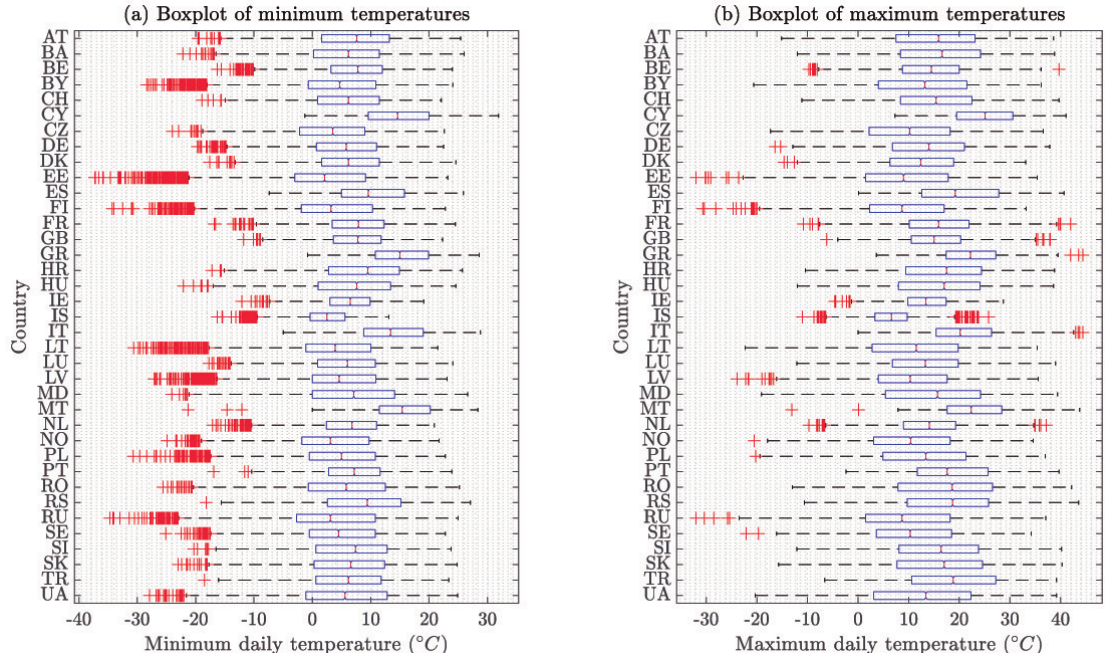
Figure 6. Boxplots for the ( a ) minimum daily temperature and ( b ) maximum daily temperature of each European country.